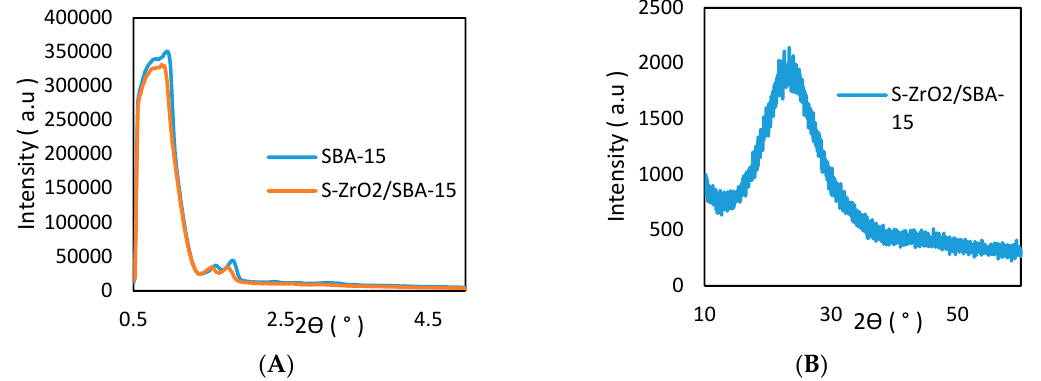
Figure 2. ( A ) Small-angle patterns of the SBA-15 support and catalyst S-ZrO 2 /SBA-15; ( B ) The large-angle X-ray diffraction (XRD) patterns of the S-ZrO 2 /SBA-15 catalyst.